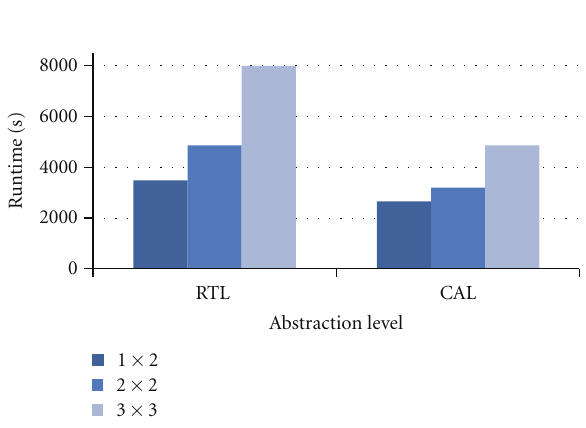
Figure 10: Results abstraction benchmark.